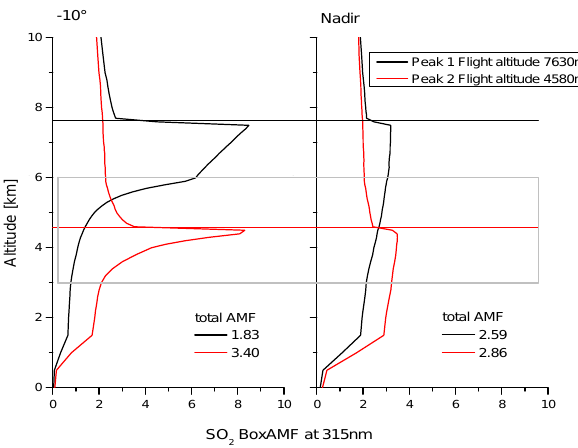
Fig. 12. BrO to SO 2 ratio inside the plume for the CARIBIC nadir data. Beside the BrO to SO 2 ratio the slope of the linear fit for the two observations is shown, ( 1 . 31 ± 0 . 16 ) × 10 − 4 and ( 1 . 17 ± 0 . 09 ) × 10 − 4 for the first and the second peak respectively. The SO 2 vertical column density is also included in the picture.